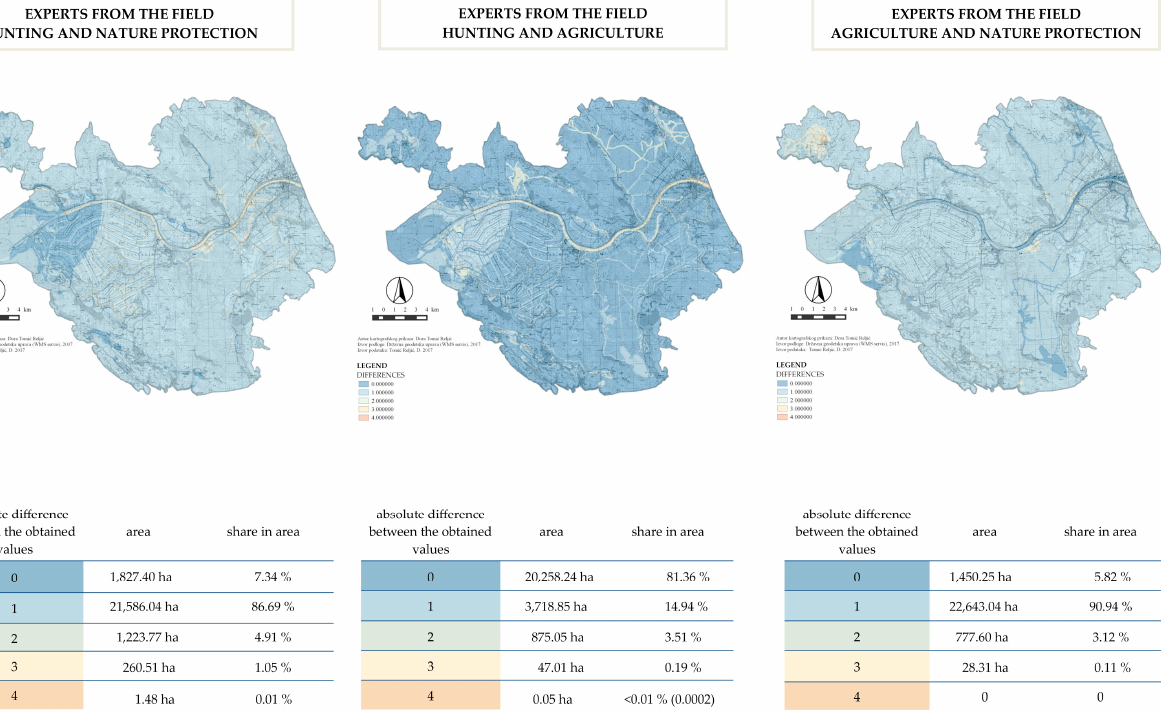
Figure 7. Cross-tabulation maps and matrices .